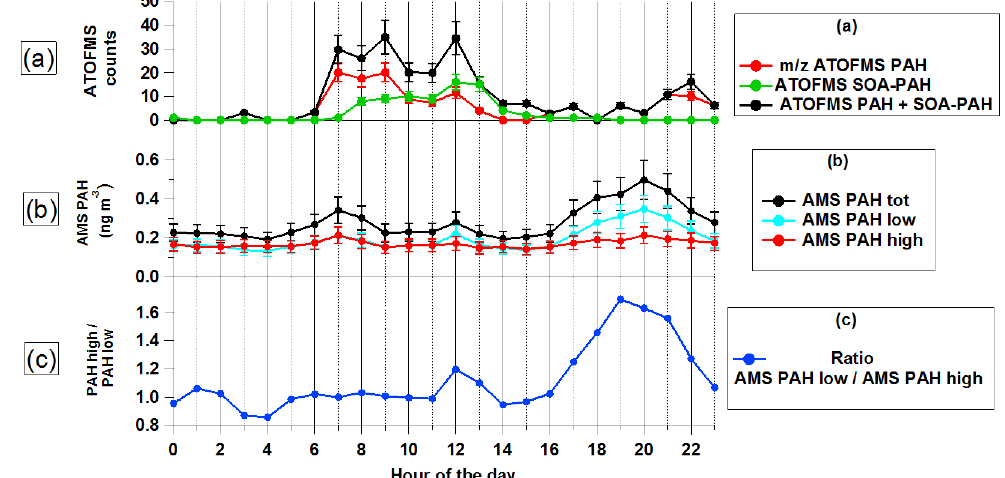
Fig. 7. PAH detection by both ATOFMS and